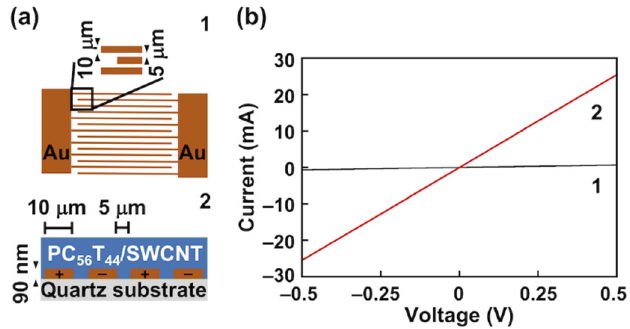
Figure 7. ( a ) Schematics showing the ( 1 ) top view of the interdigitated gold electrodes and ( 2 ) the side view of the sample configuration. ( b ) Current–voltage characteristics of the PC 56 T 44 /SWCNT composite film ( 1 ) before and ( 2 ) after photocleavage at 313 nm.